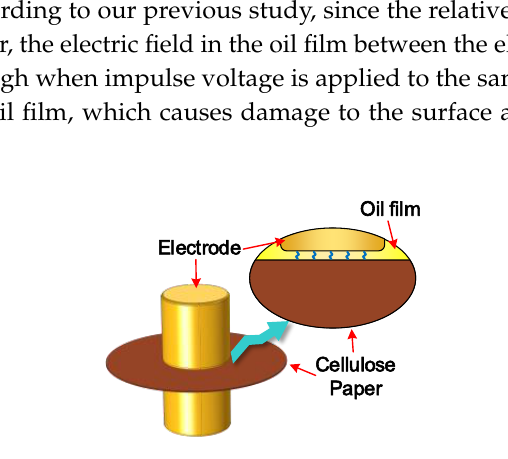
Figure 19. Oil film between electrode and cellulose paper.